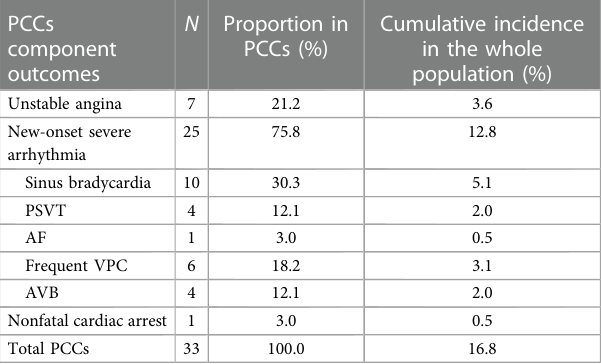
TABLE 2 Detailed information on perioperative cardiac complications.